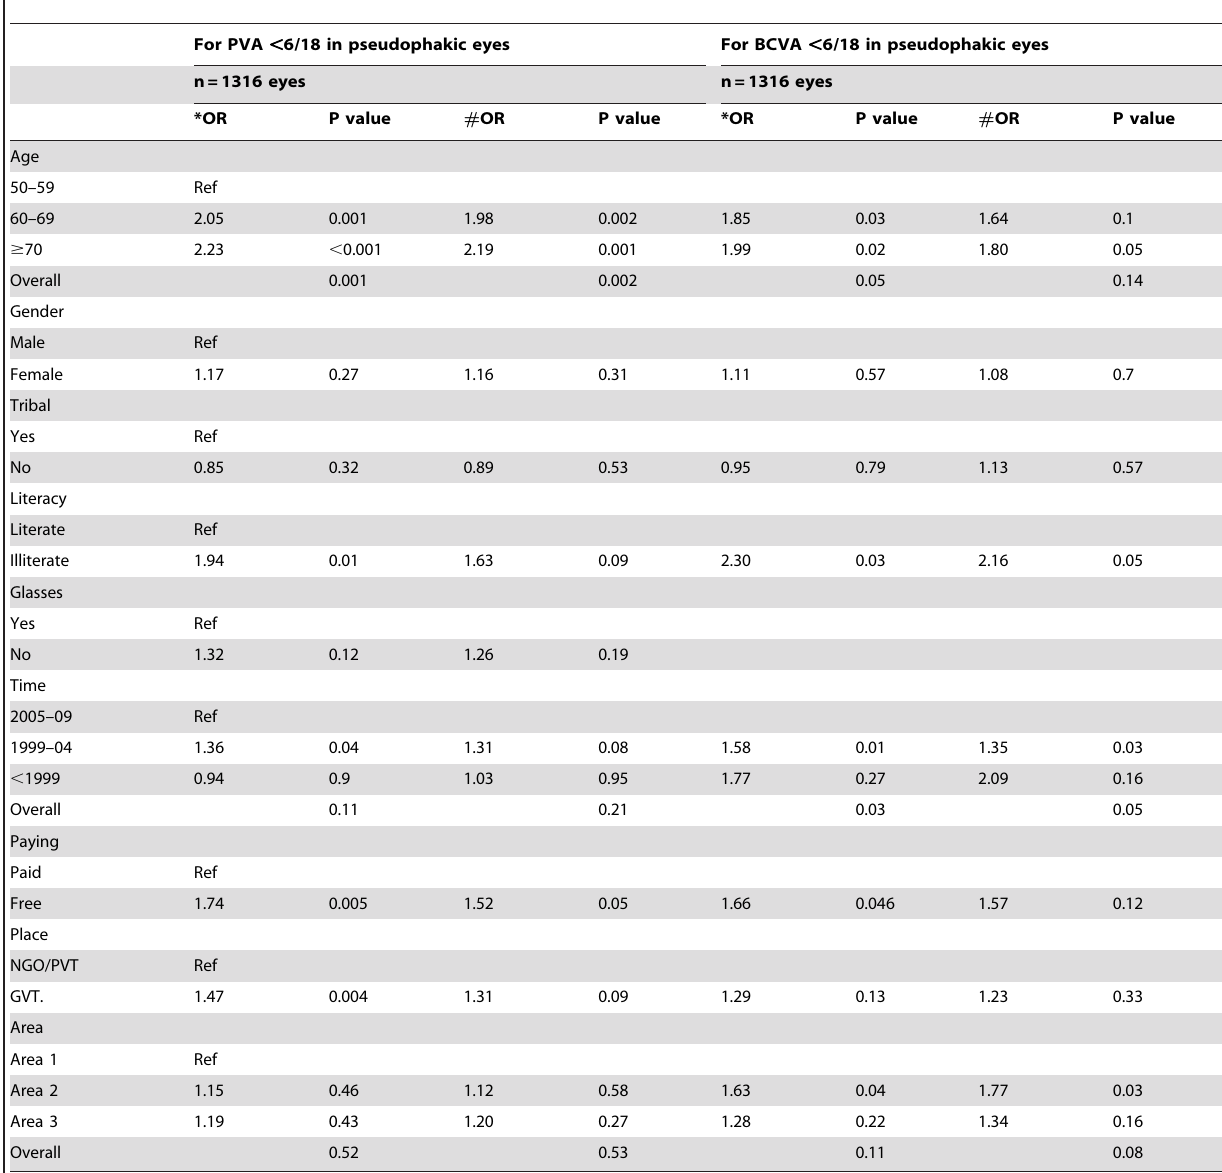
Table 4. Logistic regression showing risk factor for blindness and visual impairment for presenting visual acuity (PVA) and best corrected visual acuity (BCVA) in pseudophakic